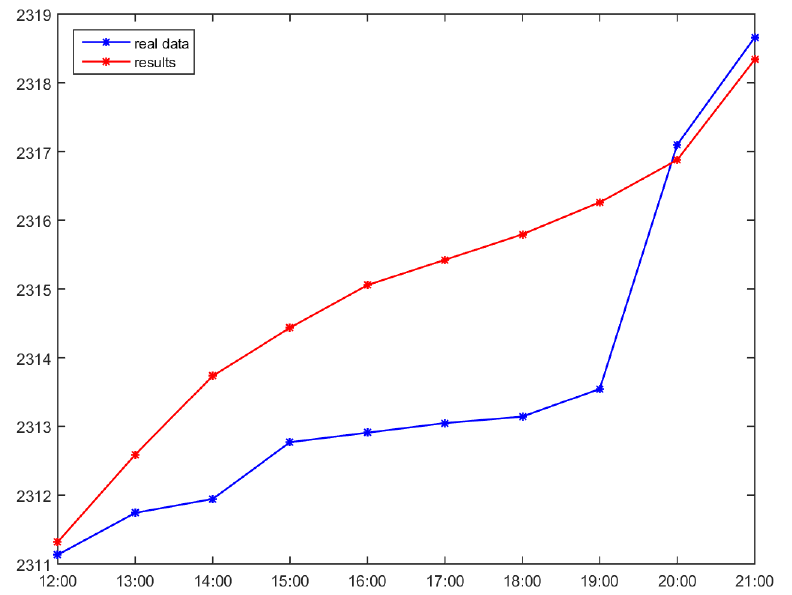
Figure 13. Comparison between the real data and the results obtained from the LSTM estimate and weight-applied compensation